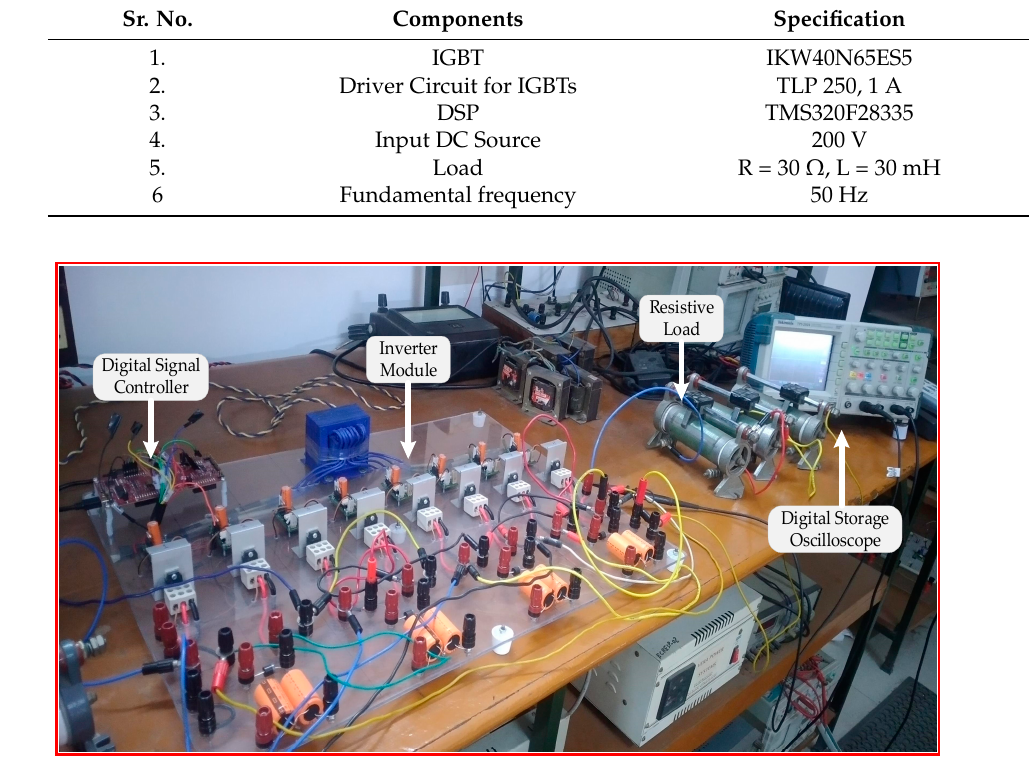
10A/div Figure 17. Voltage and current waveform at the R load.